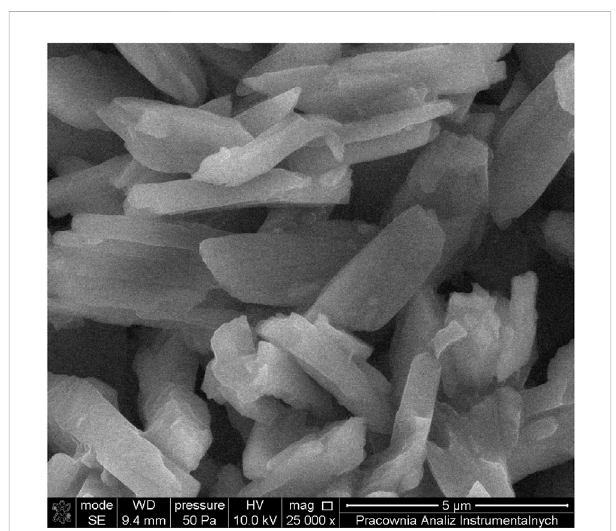
FIGURE 5 SEM image for particles synthesized from the complex [Ru(terpy)(en)(H 2 O)] 2+ via the anti-solvent process stabilized with a 0.2 mM Tween 20